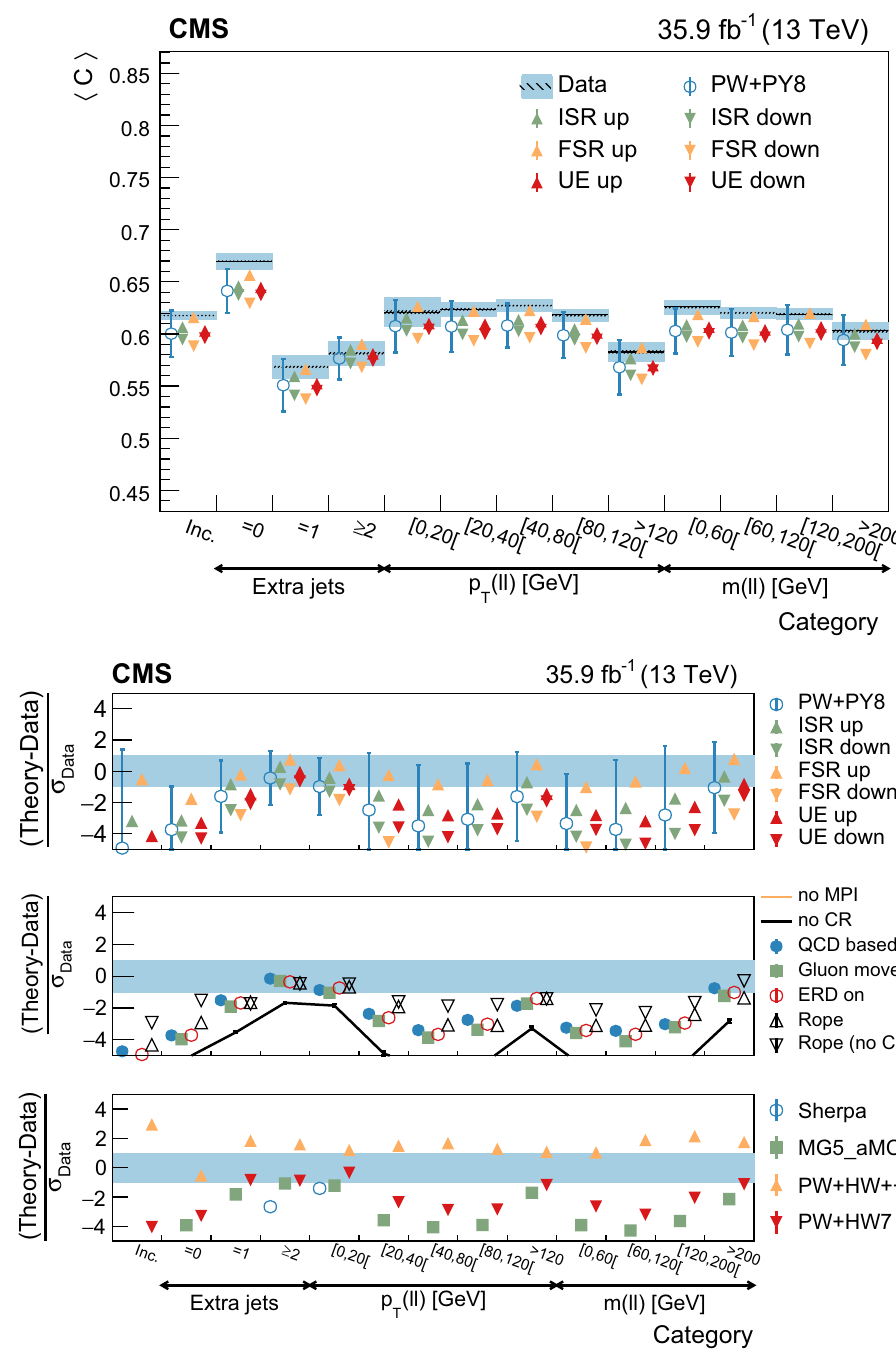
Fig. 22 Average C in different categories. The conventions of Fig. 14 are